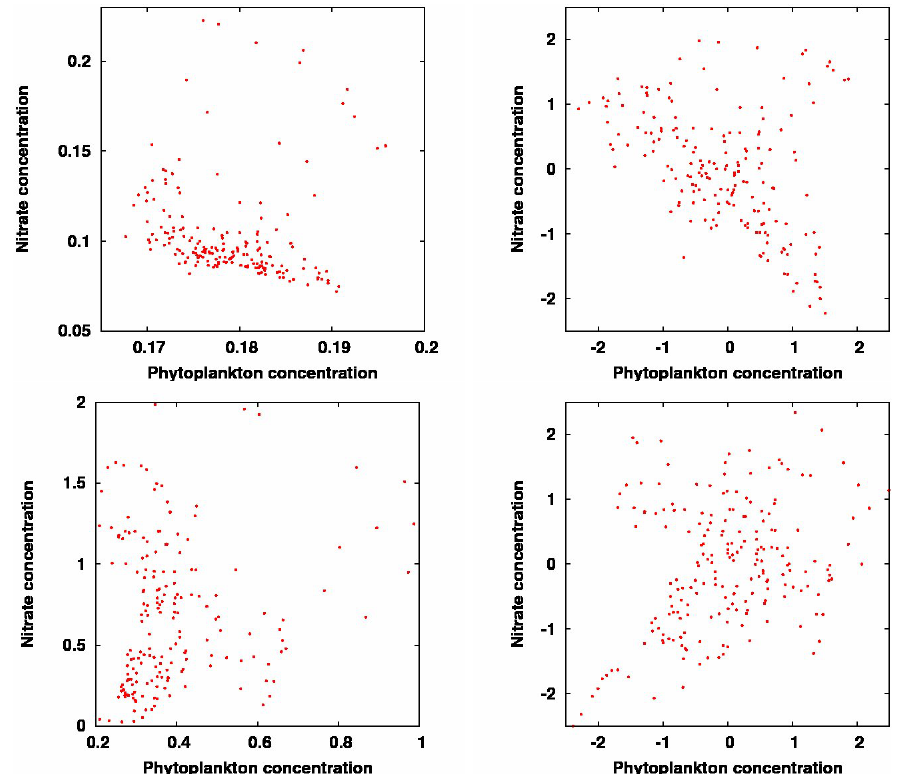
Fig. 15. Scatterplots of PHY at the reference point (20 ◦ W 35 ◦ N) vs. NO 3 at some distance from the reference (20 ◦ W 33 ◦ N), corresponding to the correlation structures that are shown in Fig. 8 (top panels) and in Fig. 14 (bottom panels), without anamorphosis (left panels) and with anamorphosis (right